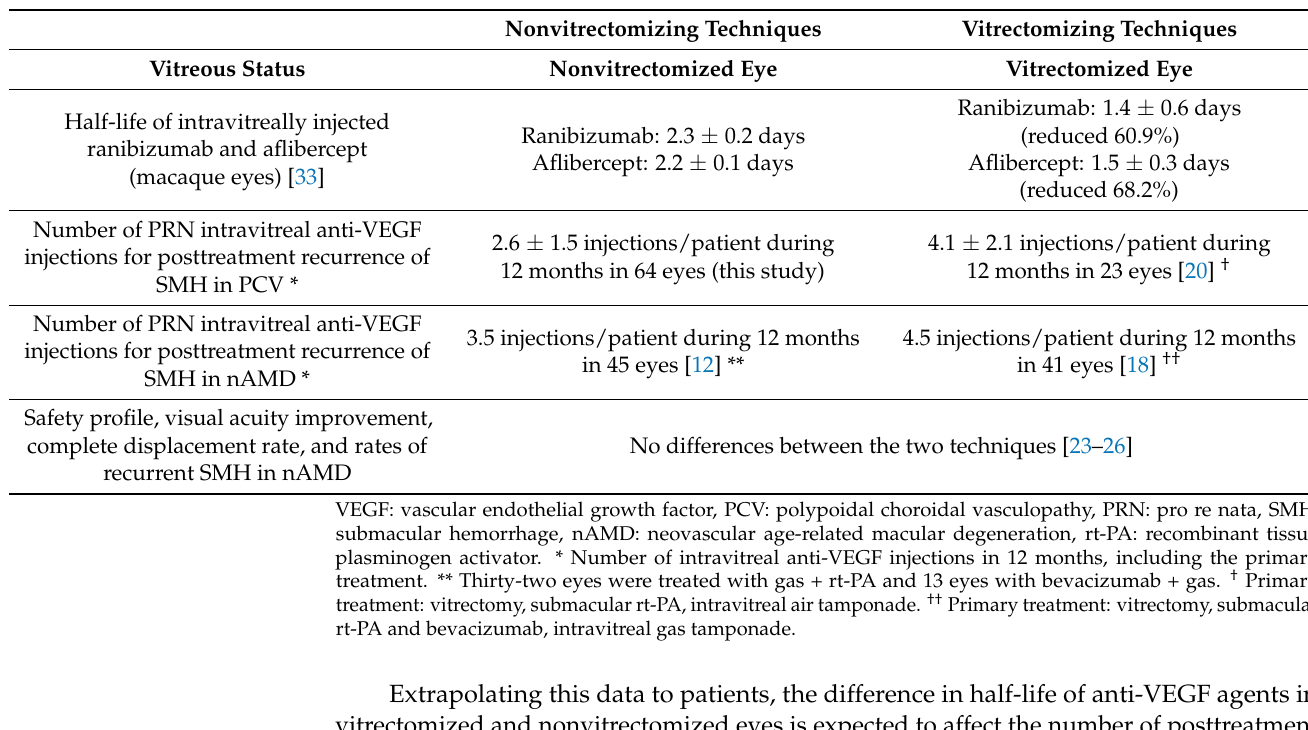
Table 4. Nonvitrectomizing Techniques and Vitrectomizing